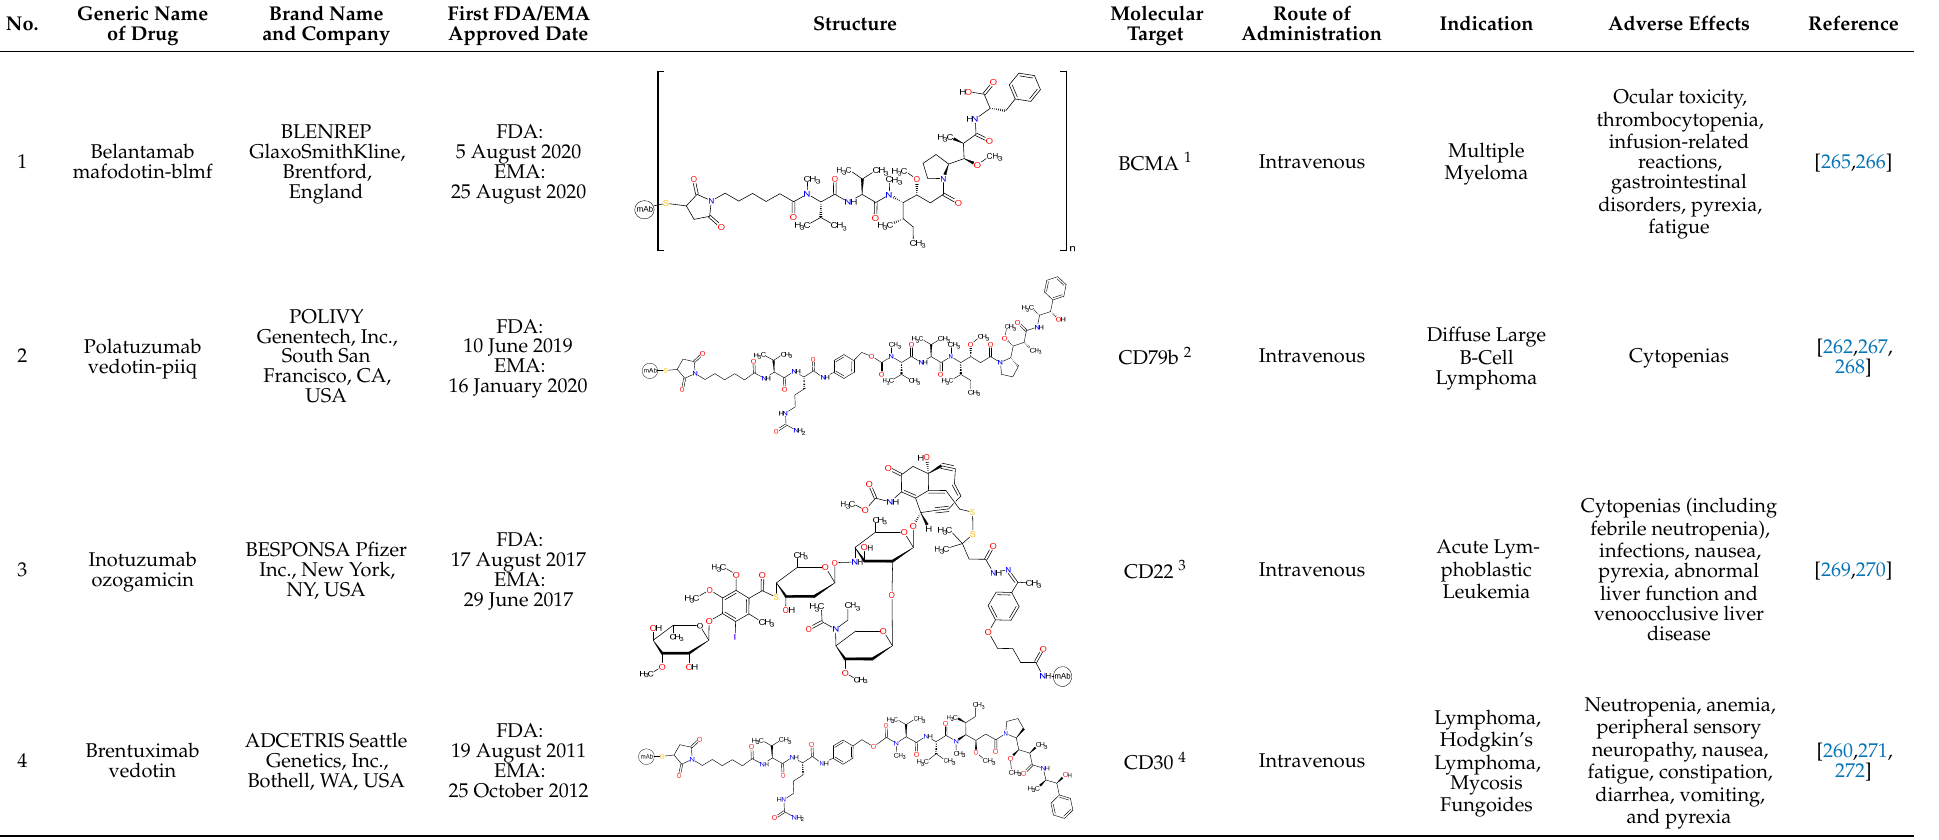
Table 13. Features of the antibody-drug conjugates approved by the Food and Drug Administration (FDA) from 2011 to 2021. The order of drugs is tabulated in order of most recent to oldest registration date.